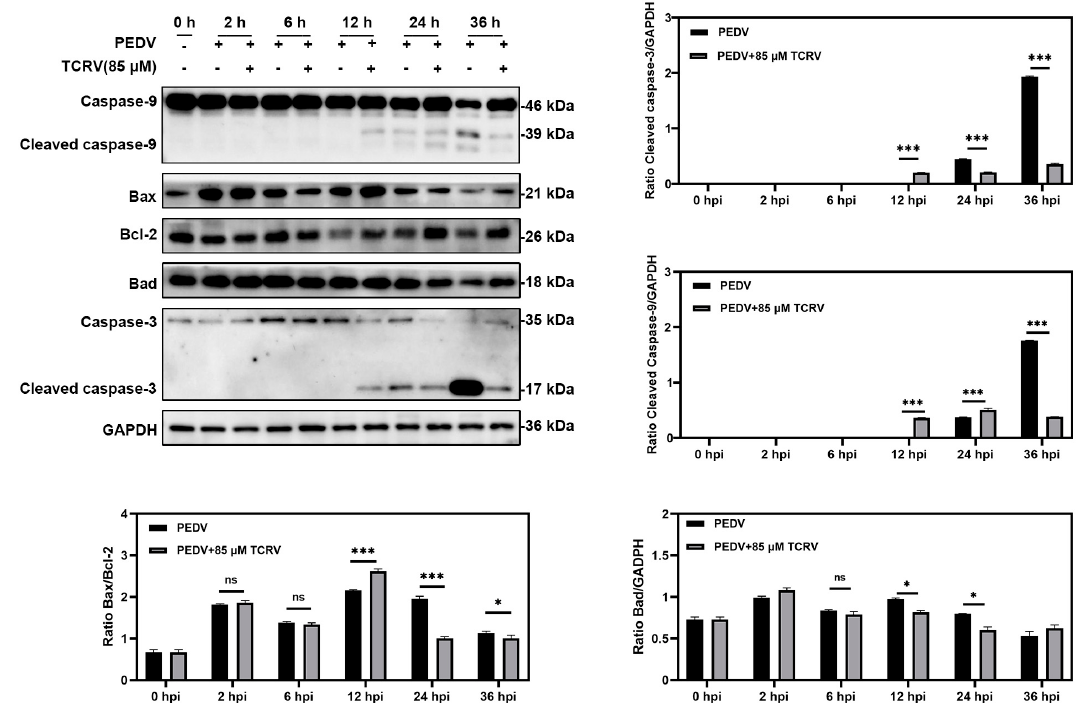
Figure 3. TCRV promotes PEDV-induced apoptosis in Vero cells. Western blotting analysis of activation caspase-3, –9, Bax, Bcl-2, and Bad proteins in PEDV-infected Vero cells treated with the indicated concentrations of TCRV at 24 hpi. Results are presented as the ratio of band intensities of the target protein to GAPDH. Data from three independent experiments and error bars are presented as the mean ± SEM. * p < 0.05, *** p < 0.001, ns, not